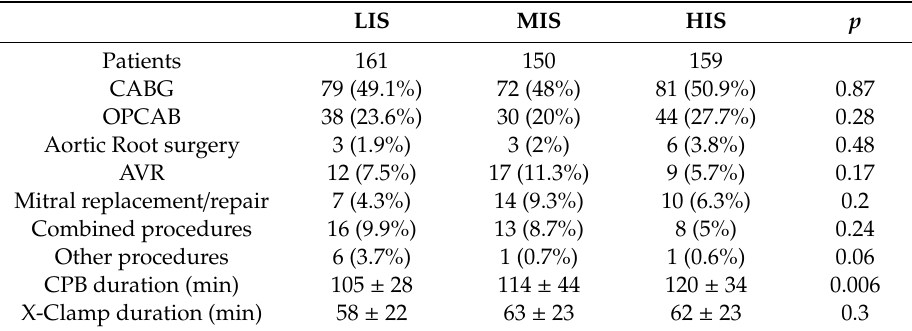
Table 2. Operative